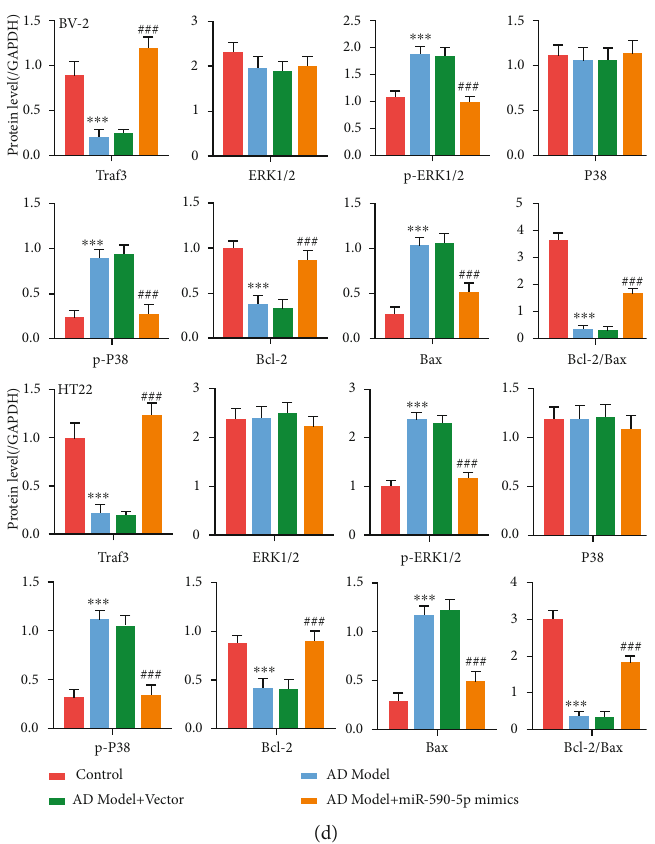
Figure 4: E ff ect of miR-590-5p overexpression on cell viability, apoptosis, and Traf3/MAPK P38 pathway in A β -induced BV-2 and HT22 cells. (a) Cell viability of BV-2 or HT22 cells treated with A β (AD model), A β +vector, and A β +miR-590-5p mimics, respectively, by CCK-8 assay. (b) The cell apoptosis of BV-2 or HT22 cells treated with A β (AD model), A β +vector, and A β +miR-590-5p mimics, respectively, by TUNEL assay (blue, nucleus; green, TUNEL-positive cells). (c, d) The expression of Traf3, phosphorylation levels of ERK1/2 and P38, and apoptosis-related proteins (Bcl-2 and Bax) in BV-2 or HT22 cells treated with A β (AD model), A β +vector, and A β +miR-590-5p mimics, respectively, by western blotting. Each experiment was repeated three times. ∗∗∗ P < 0 : 001 vs. control group; ### P < 0 : 001 vs. AD model+vector